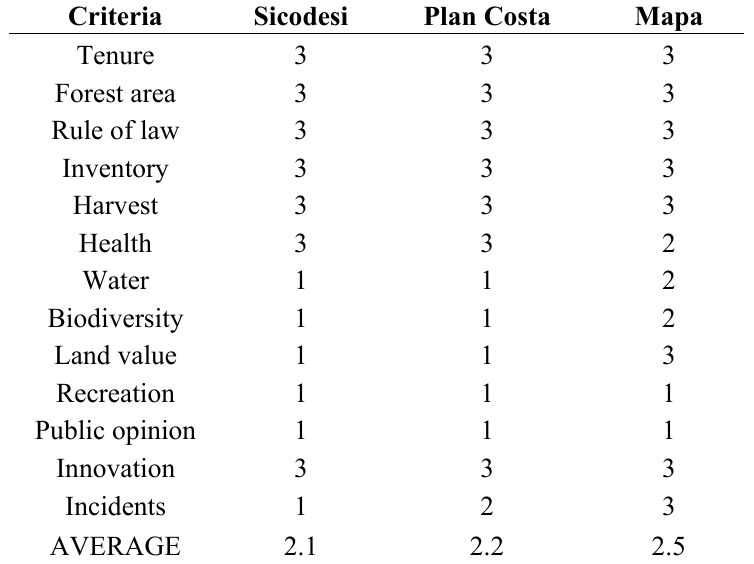
Table 1. Relative grading of performance of Sicodesi, Plan Costa, and Mapa methods. given